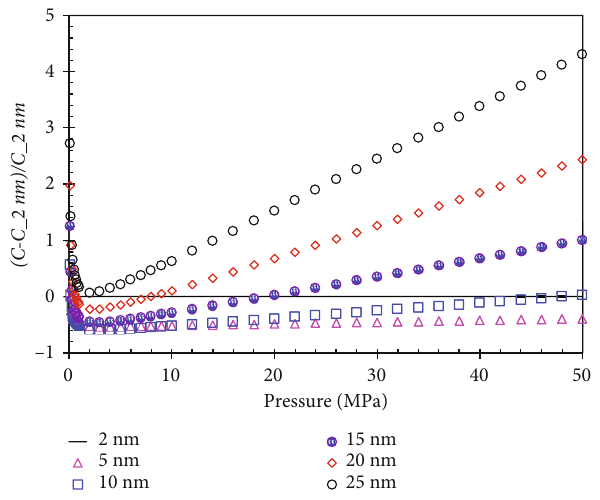
Figure 4: Comparison of total gas fl ux at a speci fi ed pore size to that of